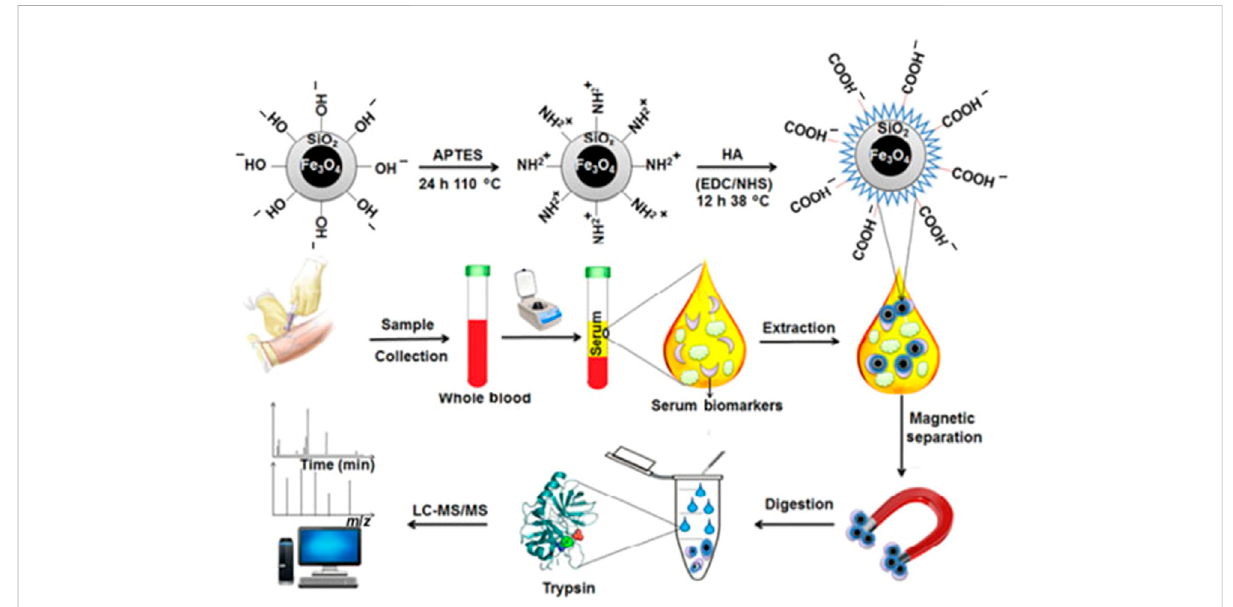
FIGURE 2 SchematicillustrationforthepreparationofFe3O4@SiO2@HAparticlesandtheirapplicationintheextractionanddetectionofbiomarkersfrom human serum samples by MS. Reproduced from ref 7. Copyright 2018